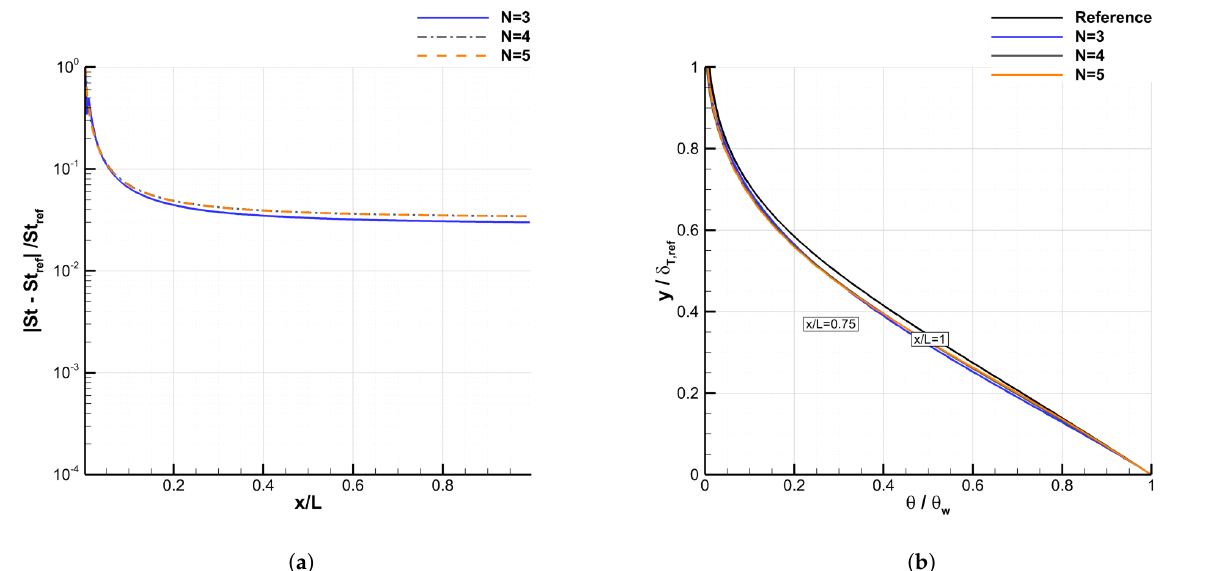
Figure 17. ( a ) Error in the Stanton number and ( b ) temperature profiles for several x / L locations.